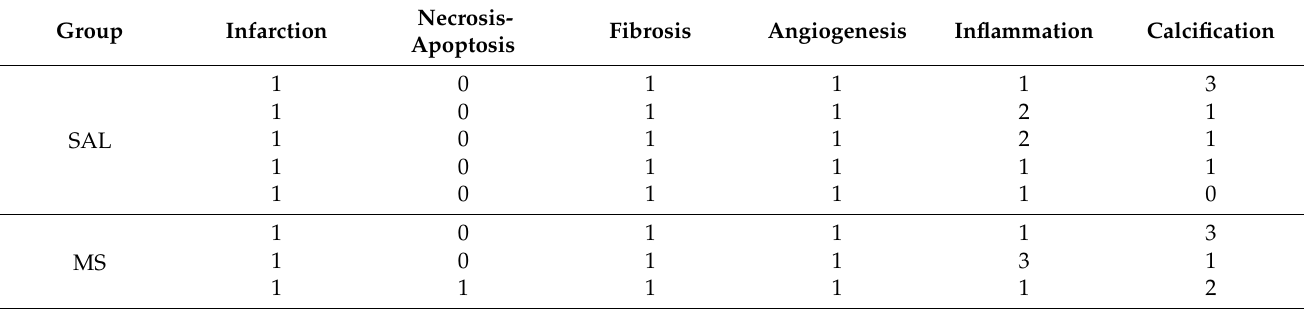
Table 8. Histological parameters of the three groups with H&E and MTC staining. Group